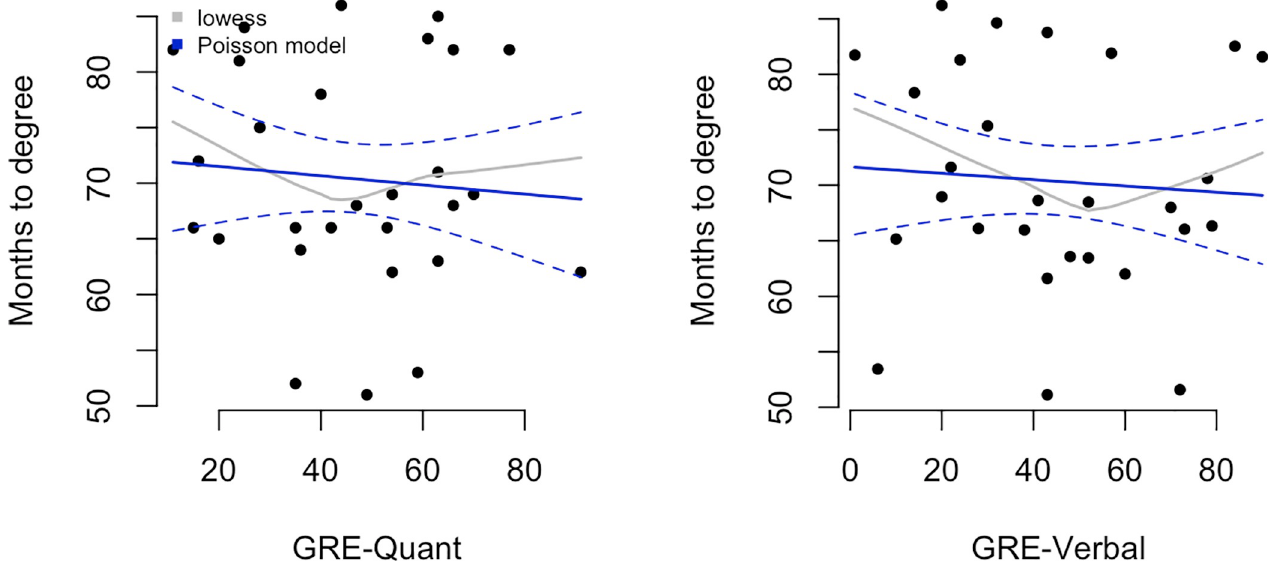
Fig 5. Associations between quantitative and verbal GRE scores and months to degree. Solid curves show the fitted values from the Poisson regression models (dashed lines are 95% confidence intervals) and the grey curves show lowess smoothers (locally weighted scatterplot smoother).